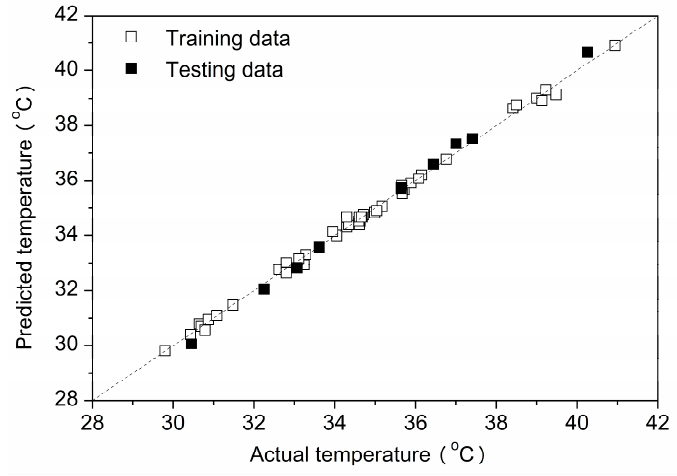
Figure 4. Predicted values versus the experimental data values. Training data and testing data were listed in Tables 2 and 3, respectively.